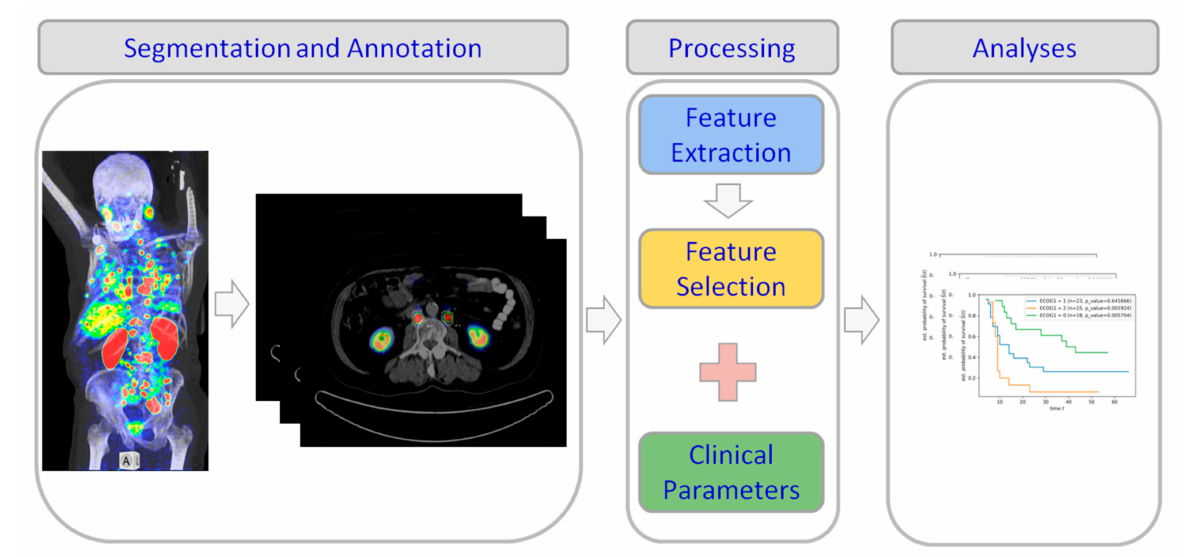
Figure 1. The study pipeline. First, the positron emission tomography/computed tomography (PET/CT) images are manually segmented and annotated by an experienced NM physician. Then the radiomics features are extracted and the most relevant features among them are chosen by LASSO method [18] to calculate the radiomics signature. Finally, the Kaplan–Meier estimator [20] is used to analyze and visualize the survival prediction results.